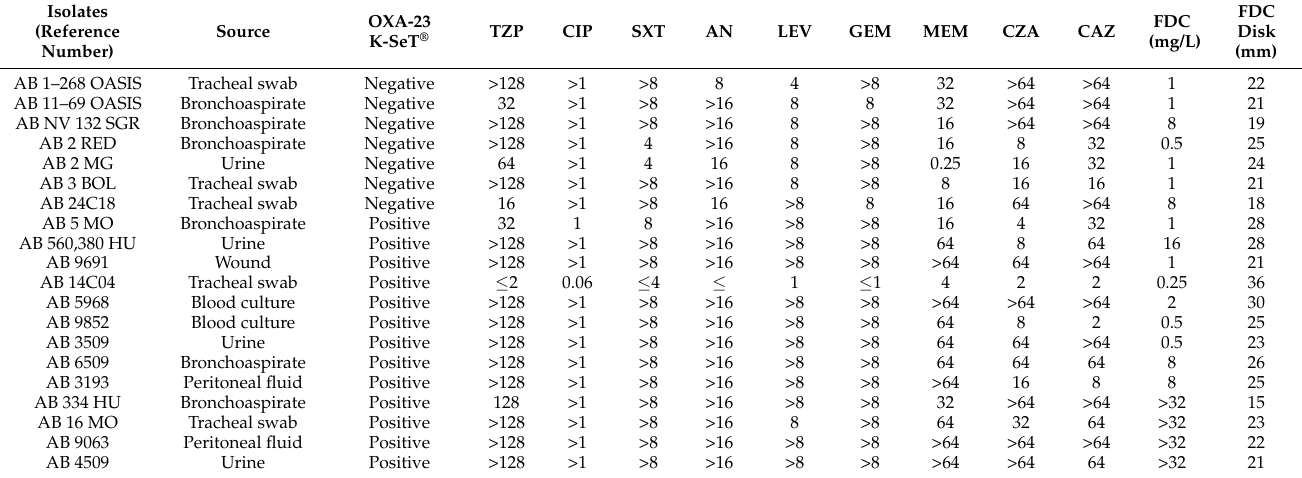
Table 1. MICs values (mg/L) of the antibiotics tested for the Acinetobacter baumannii isolates *.